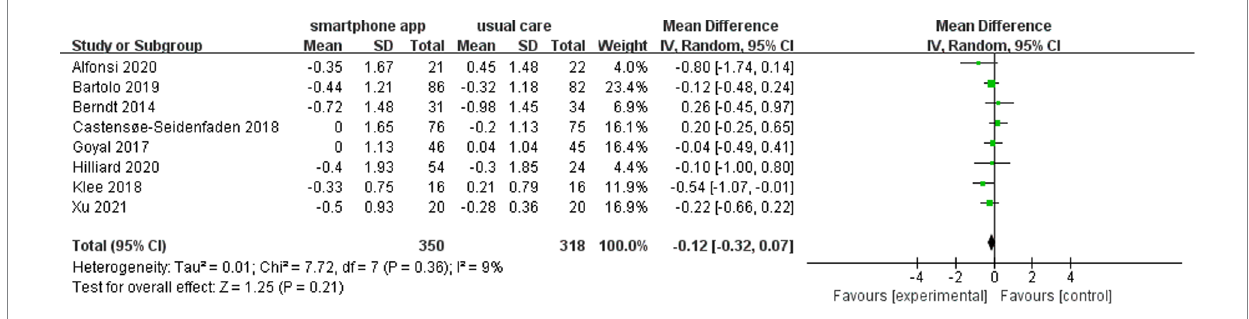
FIGURE 6 Forest plot of sensitivity analysis.